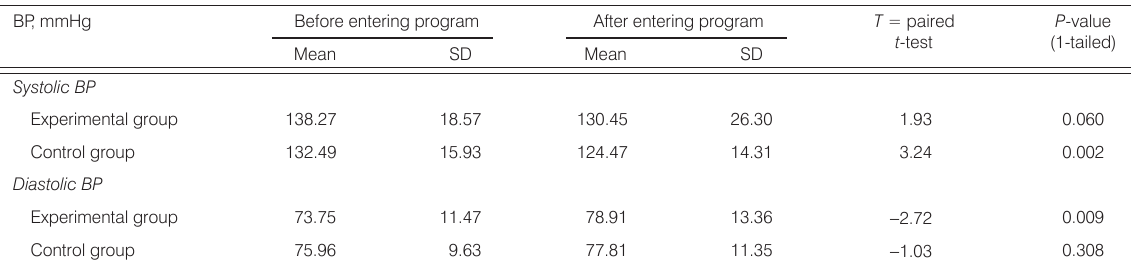
Table 3. Comparisons of decreases in systolic and diastolic BP levels between the experimental and control groups (at week 4).